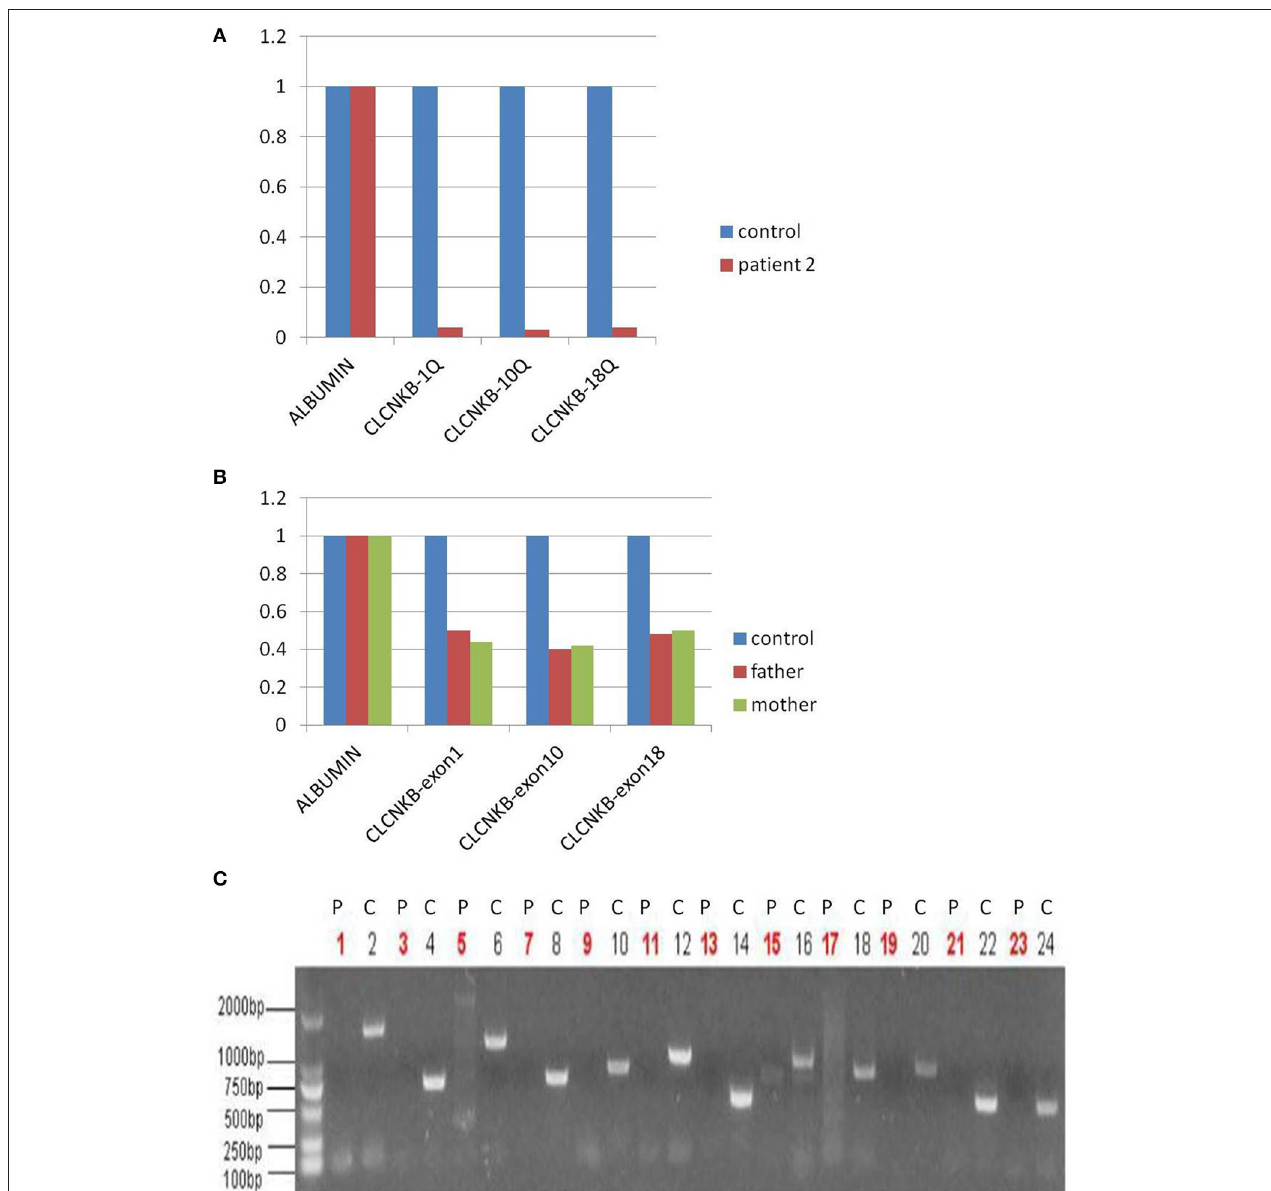
FIGURE 3 | CLCNKB q-PCR analysis of patient 2 showed a homozygous loss of exons 1–18 in CLCNKB (A) while both parents appeared heterozygous (B) . Homozygous loss of CLCNKB is also shown by absence of bands in gel-electrophoresis of CLCNKB specific PCR products specific compared to a control sample (C) . P, patient; C,